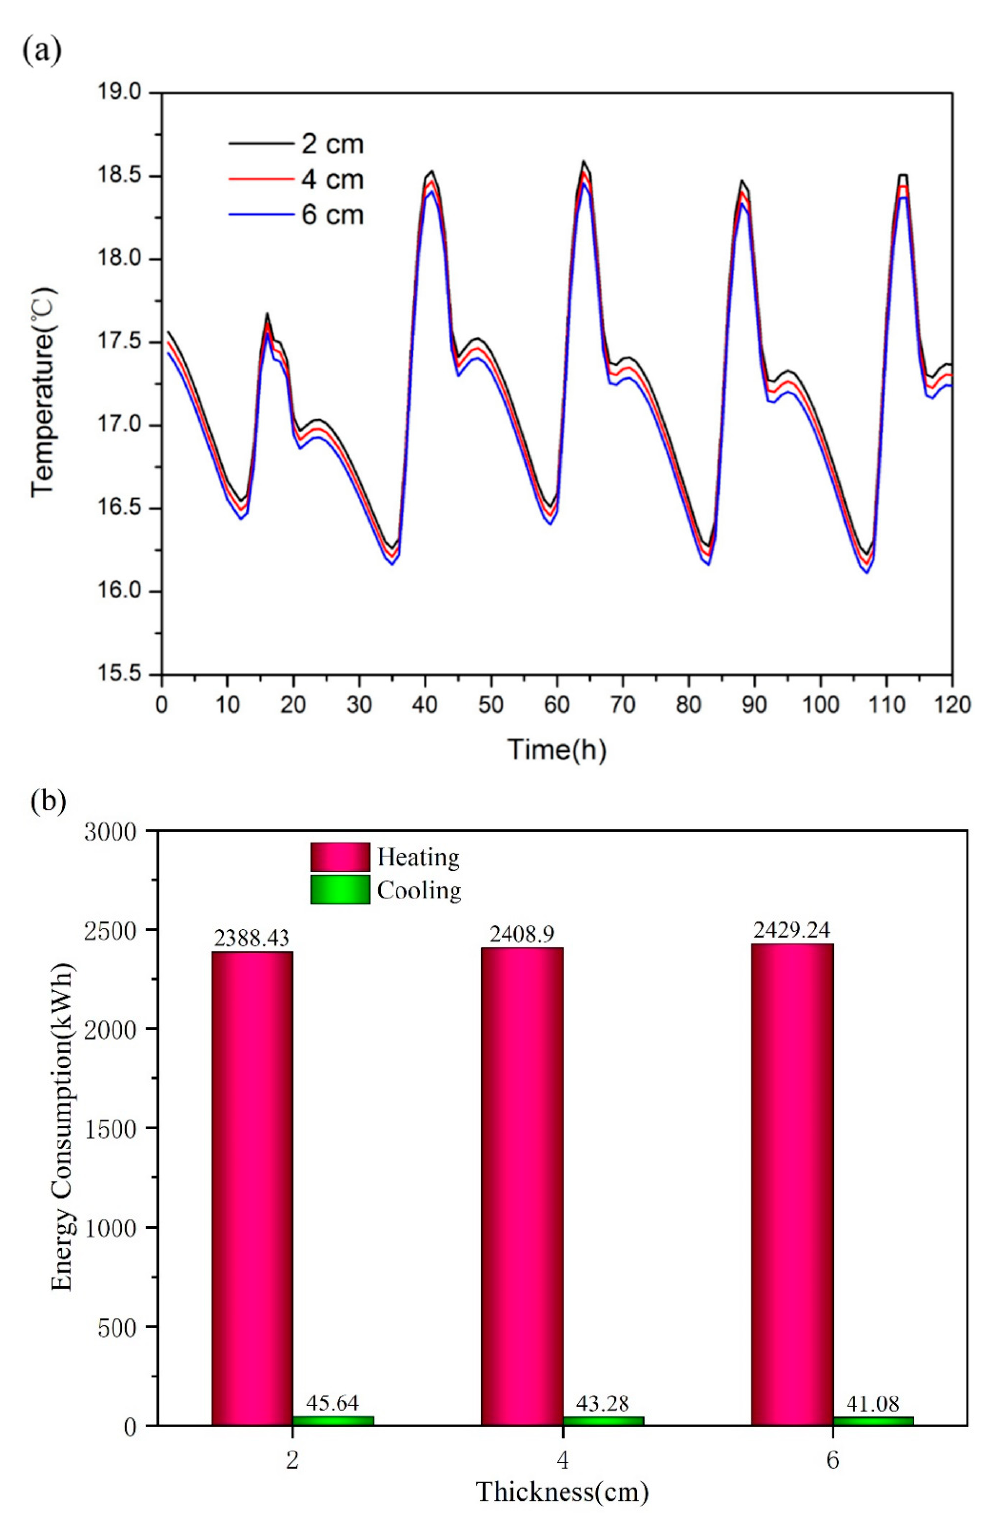
Figure 5. The inner surface temperature history of the south wall ( a ) from 21 January to 25 January and ( b ) the energy consumption of the room in the heating season under the different thicknesses of air layer 3.